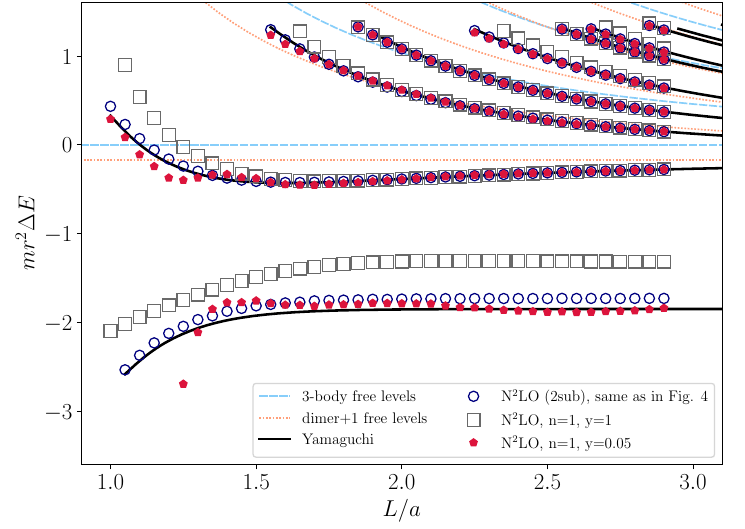
Figure 9 . The finite volume spectrum, obtained with the use of the alternative subtraction scheme. For comparison, we show the result obtained in the scheme that is considered in the main